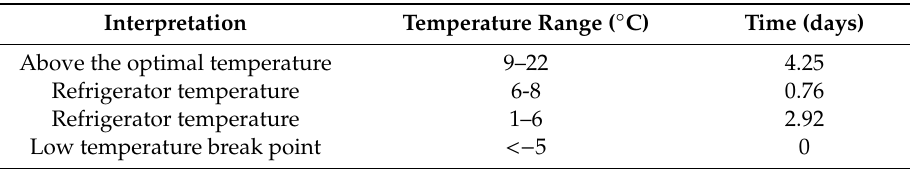
Table 5. Orange condition